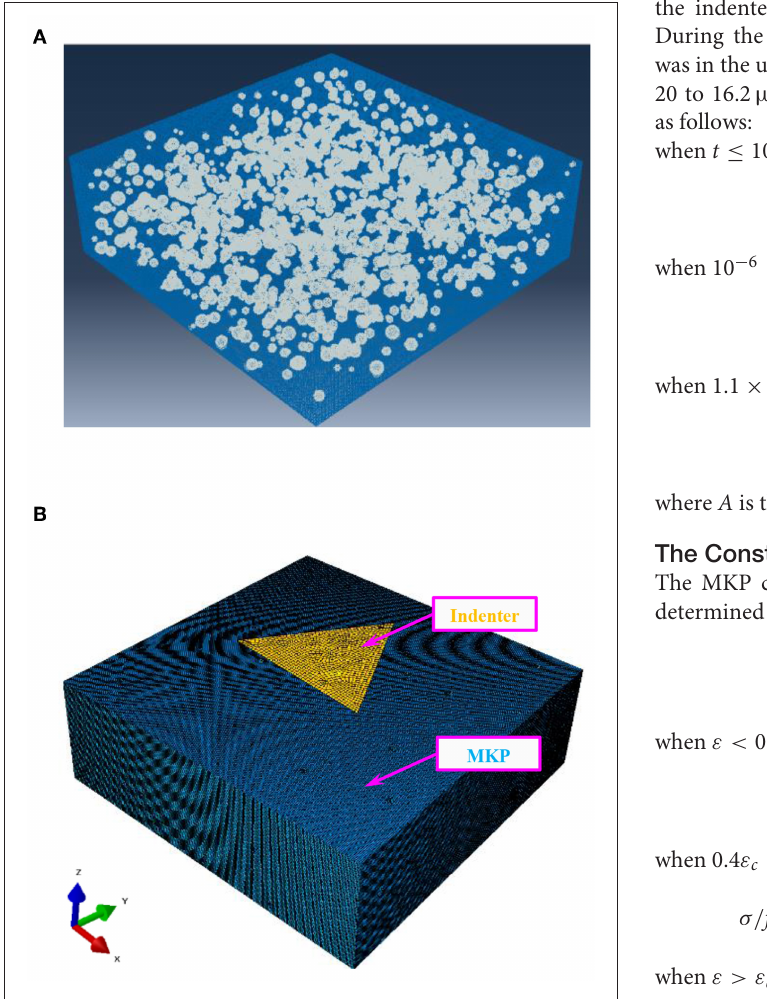
FIGURE 3 | The modeling process of P 14 indentation point based on RAP (A) the distribution characteristics of the pores; (B) the RAP nanoindentation model of the